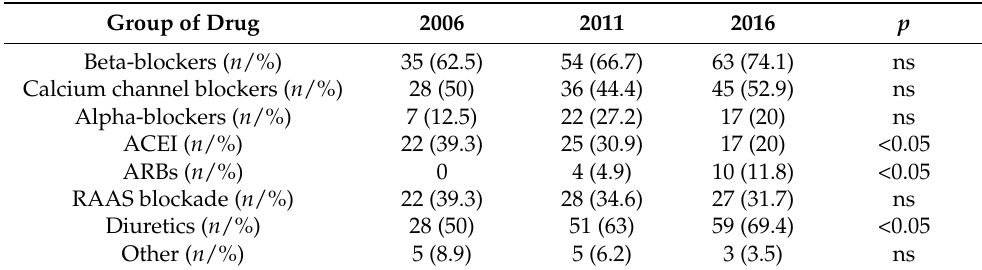
Table 4. The groups of antihypertensive drugs used in the study population. Group of